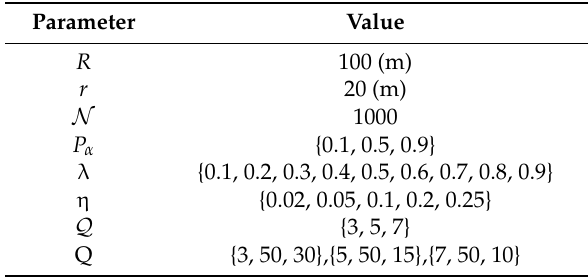
Table 5. Simulation